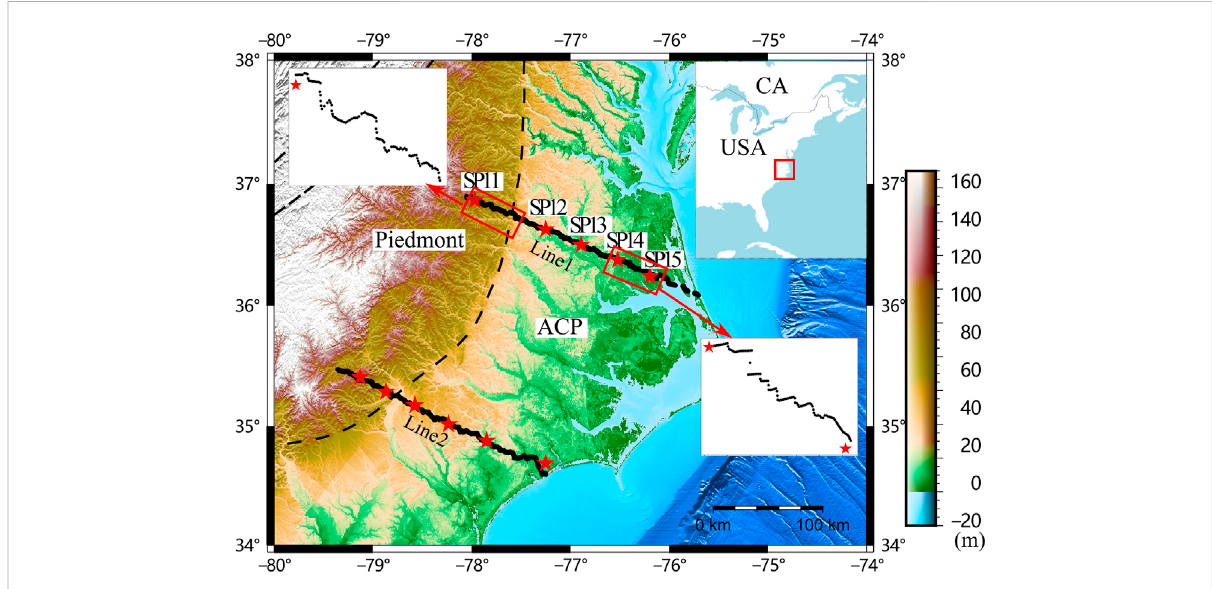
FIGURE 1 Geometry of the ENAM-CSE onshore seismic lines. The black dashed lines represent the geological terrane boundaries, and the red stars represent explosion sources. The black dots represent the seismographs. ACP denotes the Atlantic Coastal Plain. The detailed views in the fi gure show the crooked-line